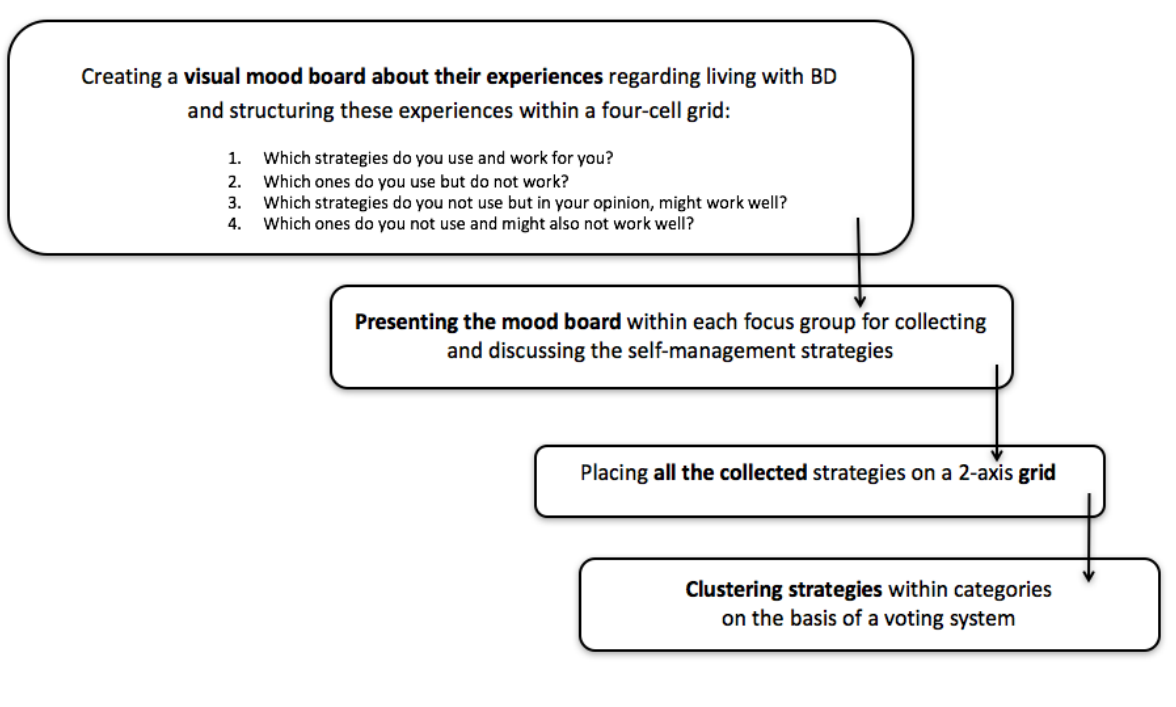
Figure 1. Flowchart on context mapping. BD: bipolar